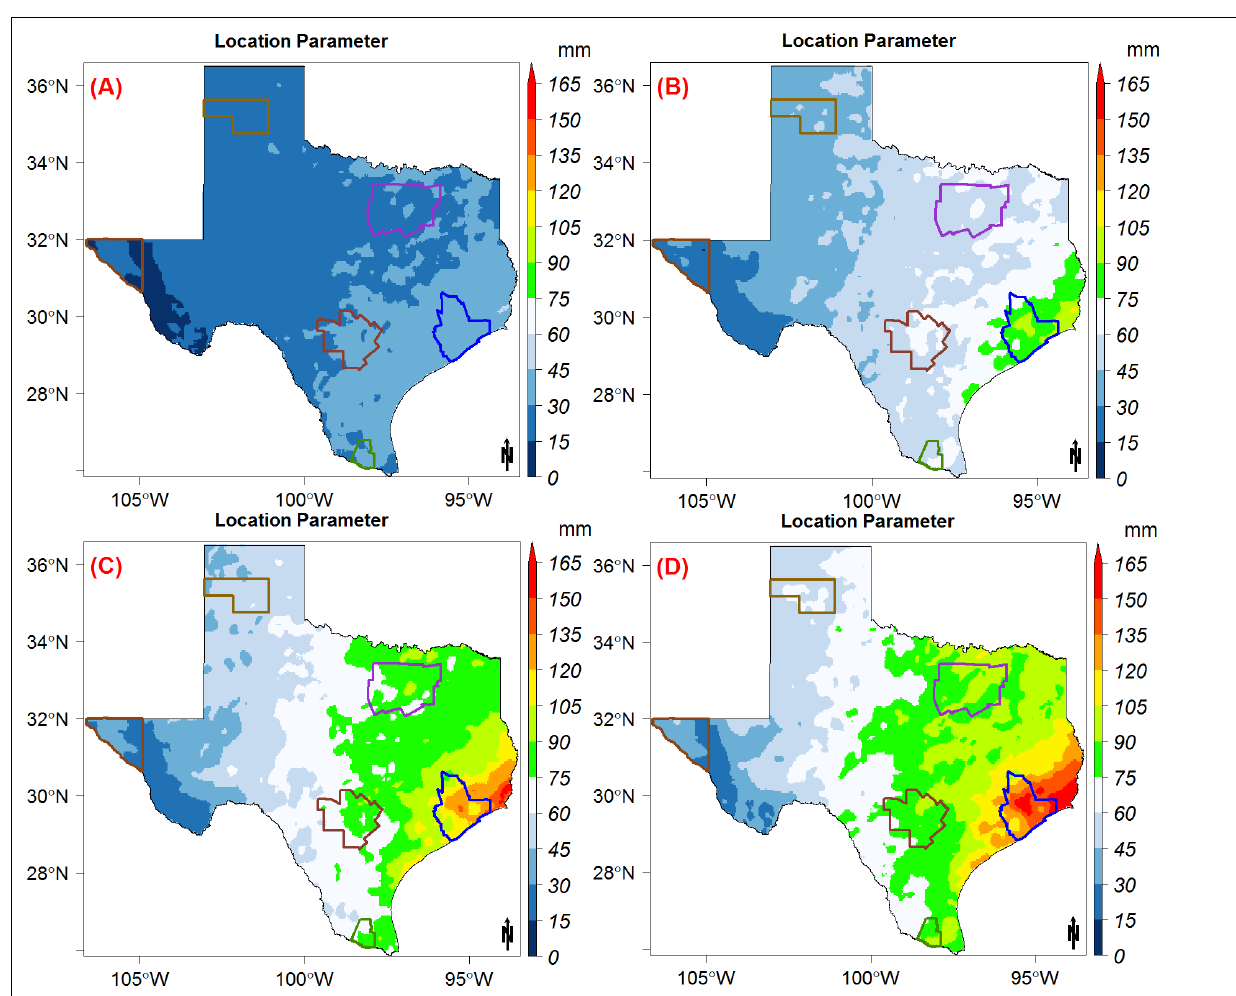
Figure A1. Location parameters of the Gumbel model distribution for the ( A ) 1-h, ( B ) 6-h, ( C ) 24-h, and ( D ) 48-h storm durations.